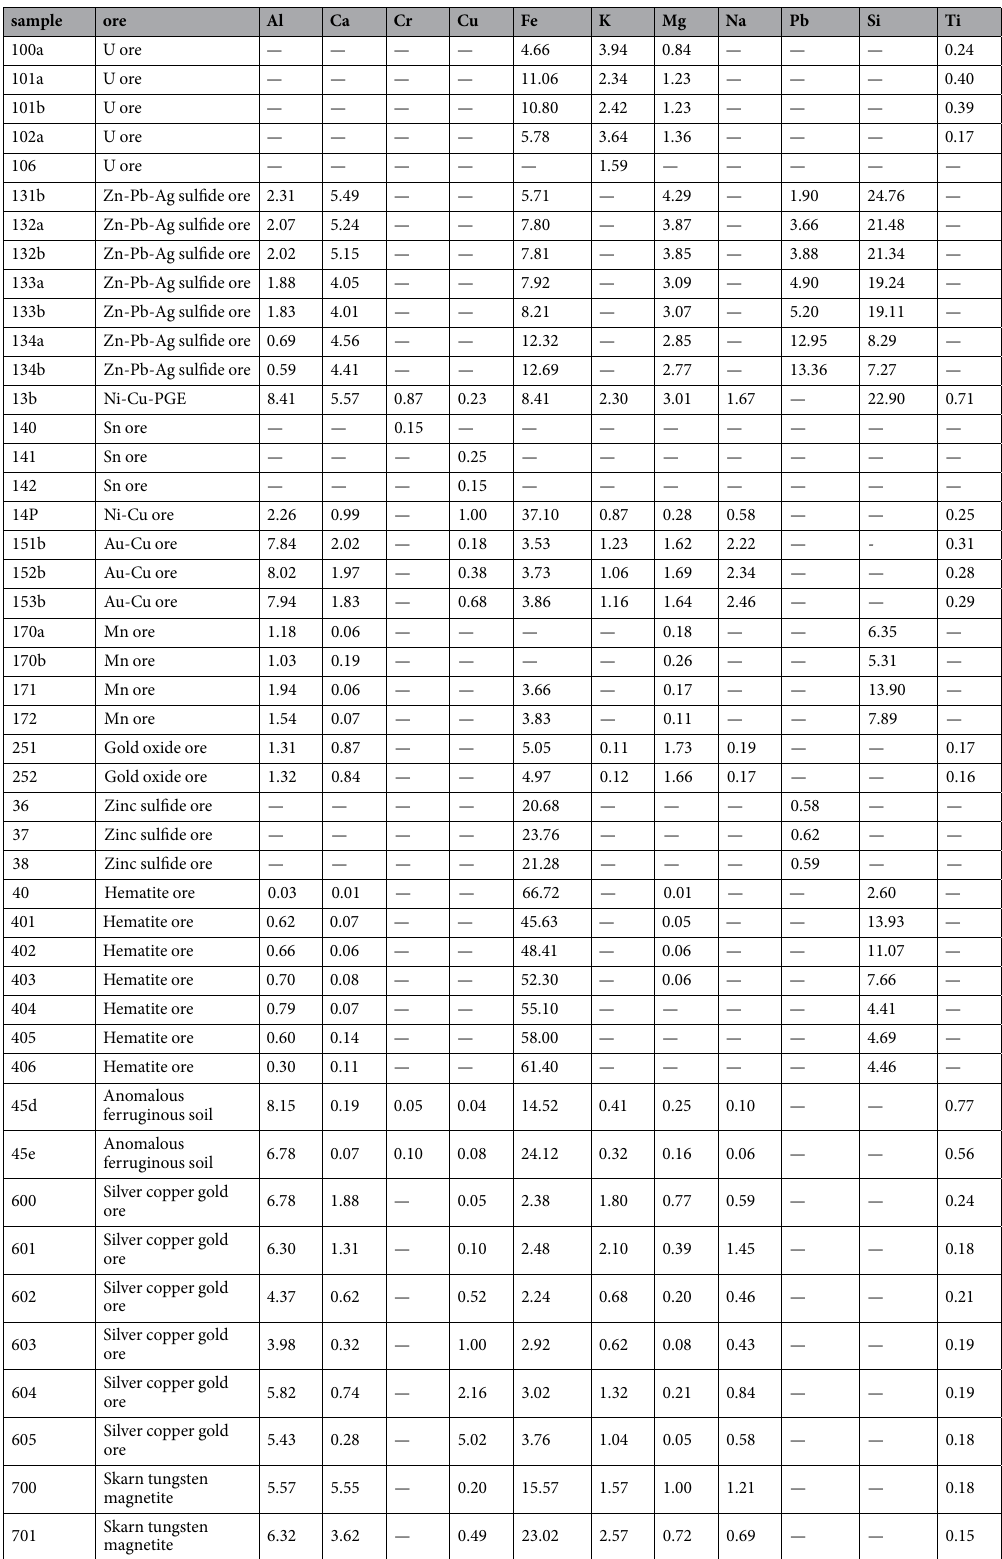
Table 2. Table containing the compositions of selected sedimentary ores as provided by the online catalogue of the producer, OREAS (Australia). Only selected elements are presented, and their contents are in wt.%. Samples 201, 202, 203, and 250 (all of them belonging to the Au-bearing ore) are not shown in the table, because no information about the content of the selected elements is present in the